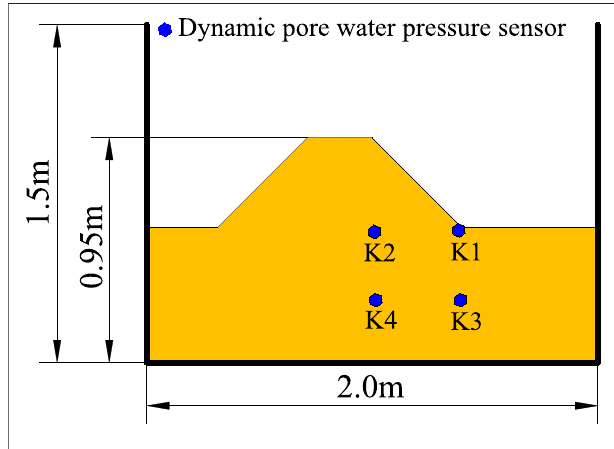
FIGURE 12 | Schematic diagram for the layout of sensors.